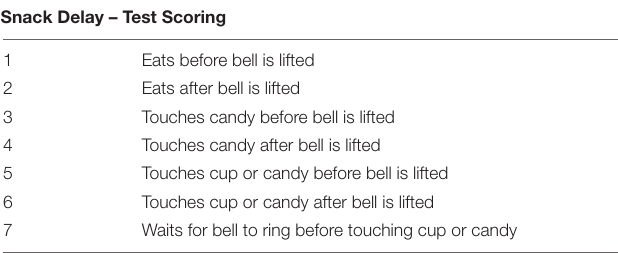
TABLE 1 | Single nucleotide polymorphisms (SNPs) included in the refined PRS for MAVAN.